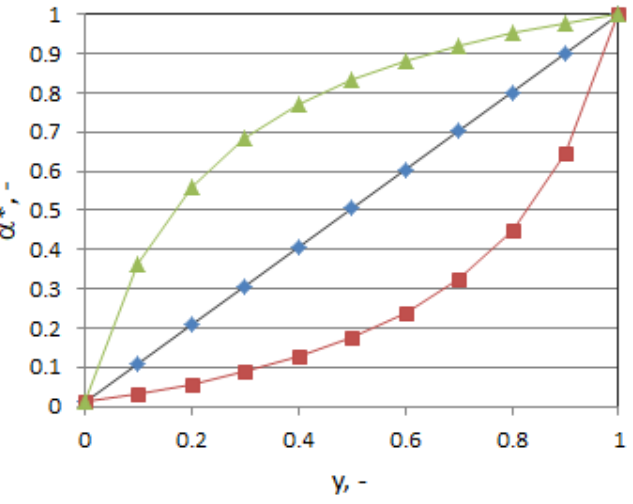
Figure 6. Change of the dimensionless Seebeck coefficient with the extent of the intermediate zone for three k 1 /k 2 ratios: diamonds k 1 /k 2 = 1; squares k 1 /k 2 = 1/5; triangles k 1 /k 2 = 5/1. α 1 / α 2 = 1/100.